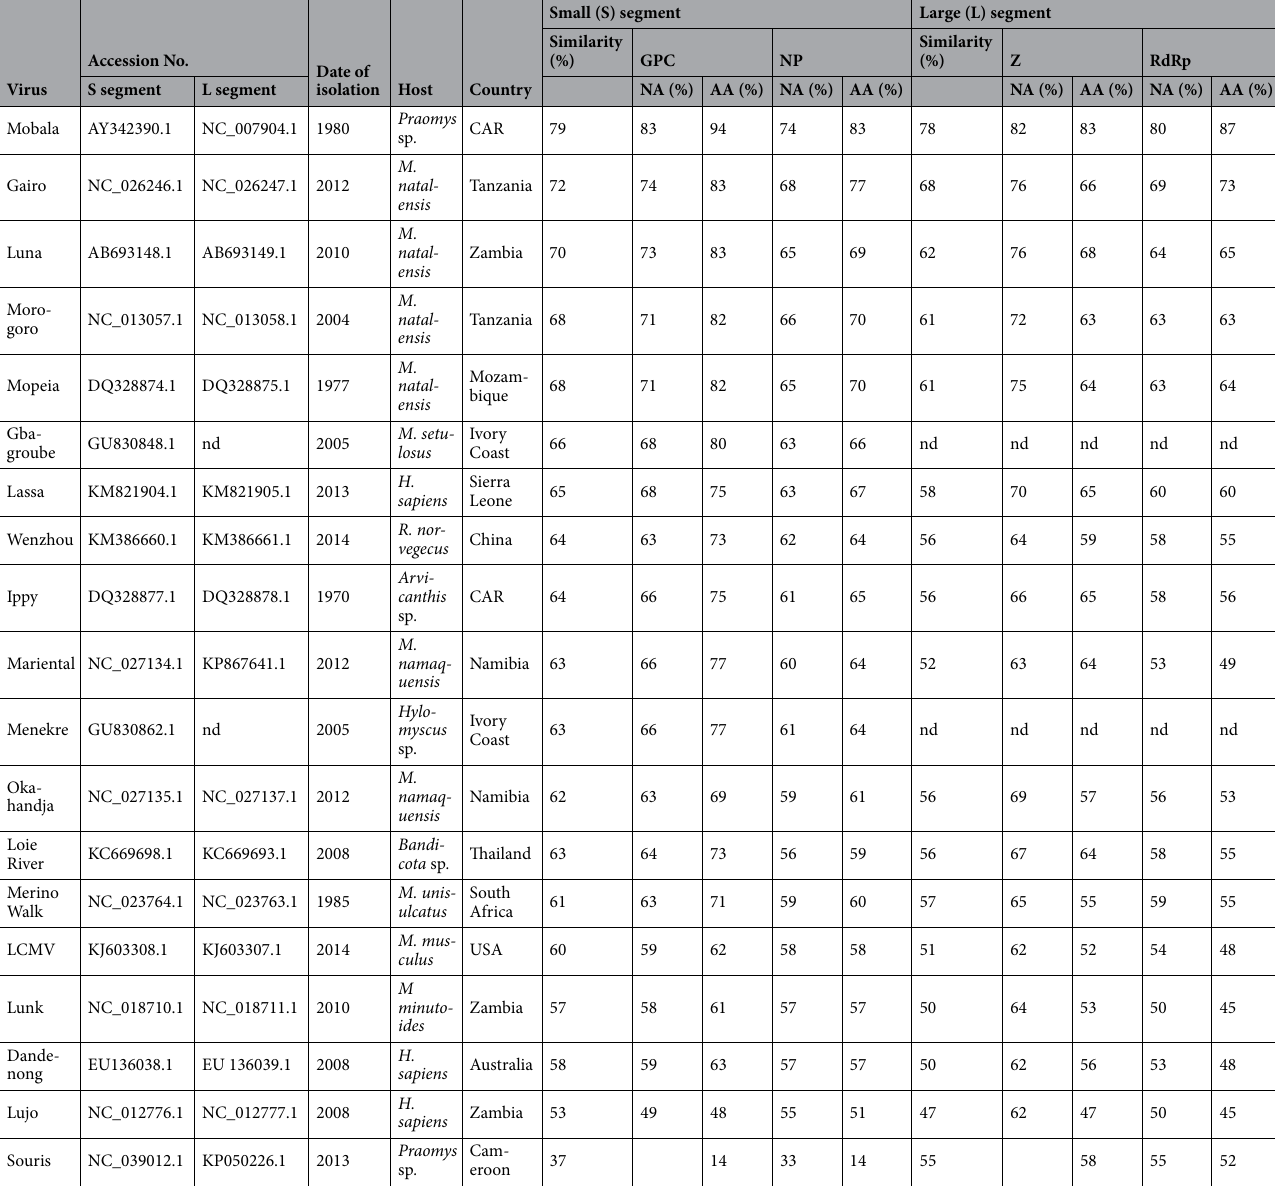
Table 2. Similarities of strain AnRB3214 with other Old-World arenaviruses at the nucleic acid (NA) and amino acid (AA) level and accession number. GPC: glycoprotein precursor; NP: nucleoprotein; Z, zinc-binding protein; RdRp: RNA-dependent RNA polymerase; CAR: Central African Republic; nd: no data, the L segment sequence is not available; M. natalensis : Mastomys natalensis ; M. setulosus: Mus setulosus ; R. norvegecus: Rattus norvegecus ; M. namaquensis : Micaelamys namaquensis ; M. musculus : Mus musculus ; M. minutoides : Mus minutoides ; H. sapiens :